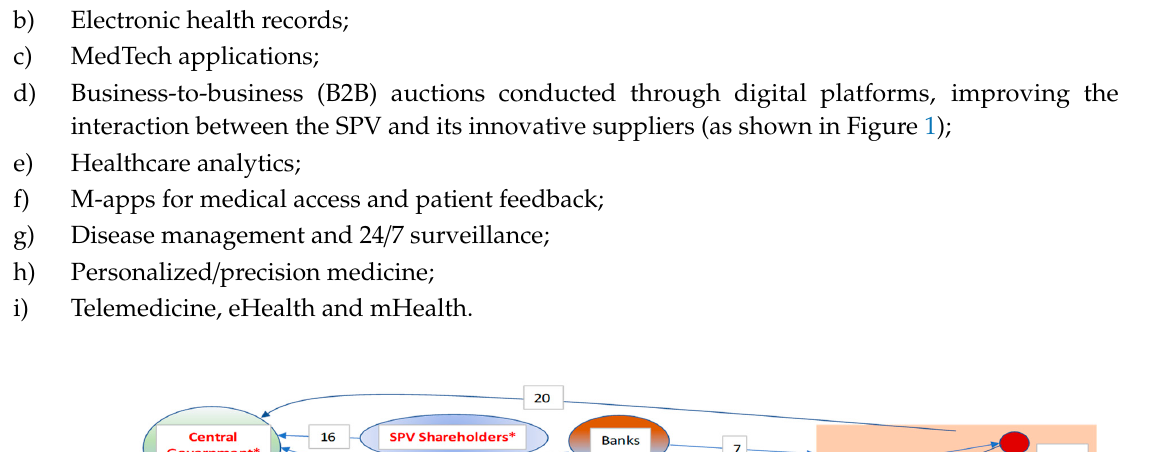
Value co-creation and softening of supply chain bottlenecks through a digital healthcare platform.